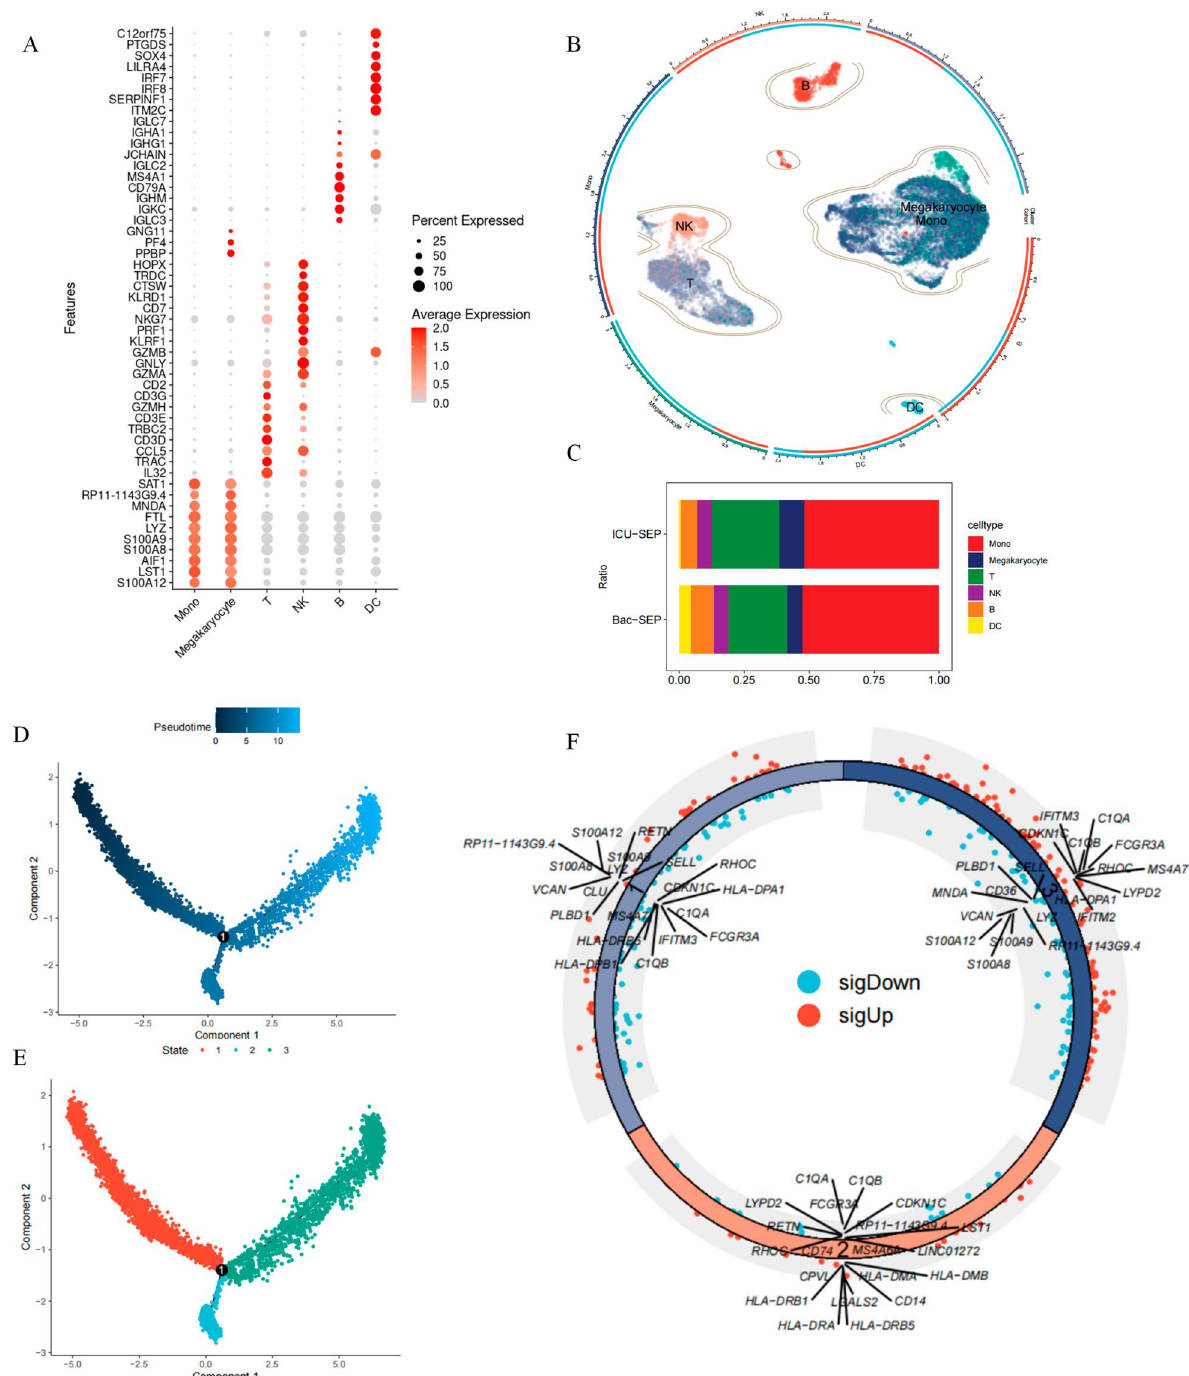
Fig. 2 Analysis of monocyte differentiation trajectories. A Expression of marker genes used in the cell annotation process. The size of the bubble represents the percentage of cells in that cell subpopulation that express the gene. From gray to red indicates higher gene expression values; B Landscape of single-cell annotation; C Percentage of each cell type in different cohorts; D Monocyte differentiation trajectories. The pseudotime represents the order of differentiation time, the darker the color means the more biased to the early stage of differentiation, the lighter the color, the more backward the differentiation time sequence; E Monocyte differentiation states. Red represents state 1 cells, blue represents state 2 cells, and green represents state 3 cells. Cells start to differentiate from state 1, after which they partly differentiate to state 2 and partly to state 3; F Differentially expressed genes for each cell state. Differentially expressed genes were determined for each state by a Wilcoxon rank-sum test, with a screening bar of |logFC| > 0.585 adjusted for P < 0.05. Blue represents down-regulated genes, red represents up-regulated